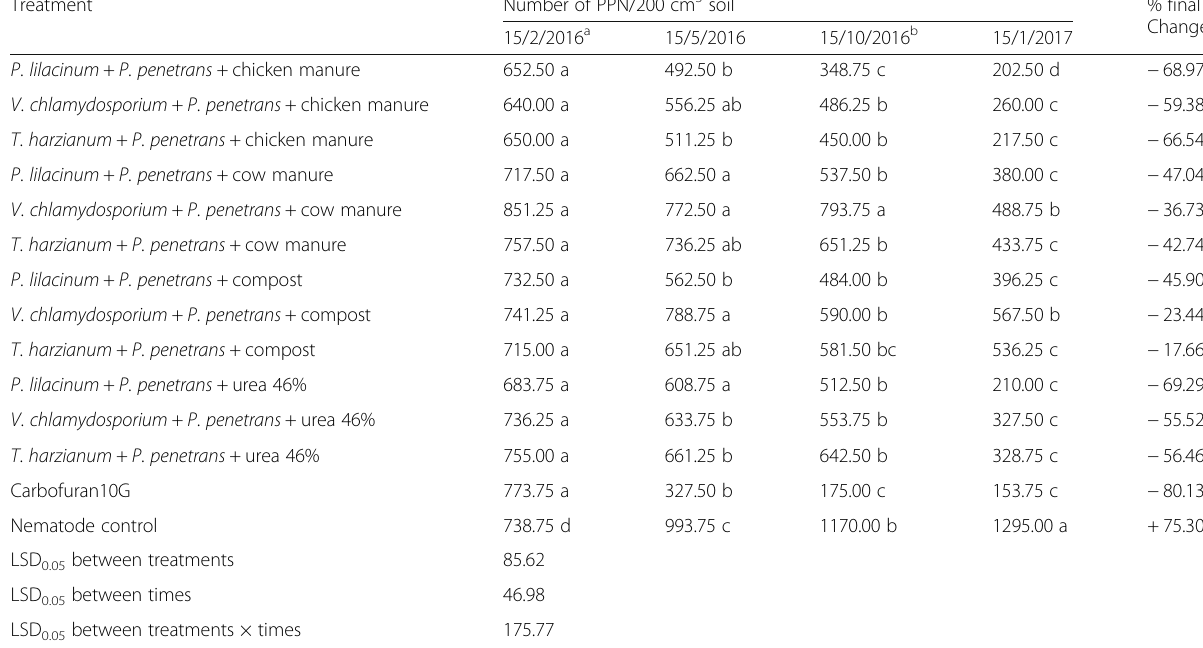
Table 2 Effect of different combinations of integrated control measures on the number of plant-parasitic nematodes (PPN) associated with guava, Psidium guajava , rhizosphere Treatment Number of PPN/200 cm 3